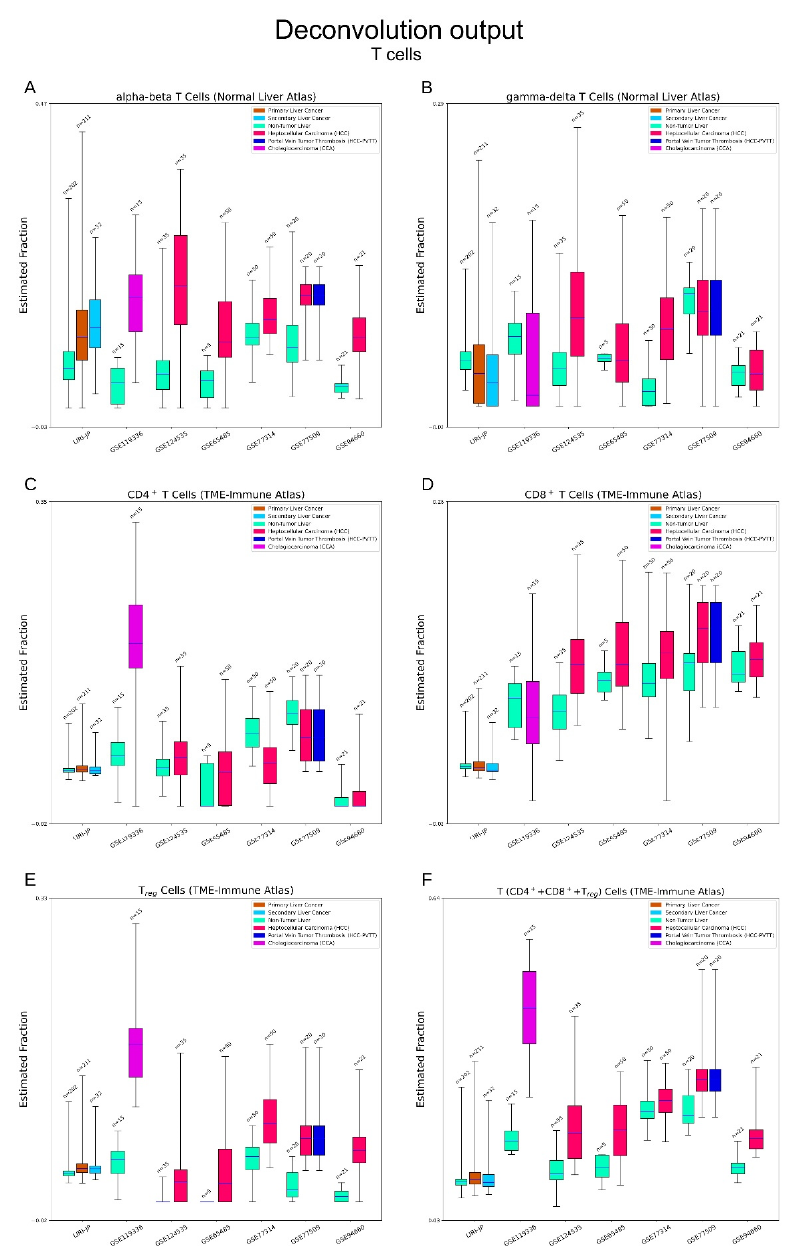
Figure 4. Deconvolution output—T cells. ( A – E ) Estimation of T cells. Alpha–beta ( αβ ) T cells and gamma–delta ( γδ ) T cells are from the Normal Liver atlas. CD4 + /CD8 + T cells and regulatory T (T reg ) cells are from the TME-Immune atlas. Overlap of cell type trees may exist between the two atlases. Obvious elevations of αβ T cells and obscure changes of γδ T cells can be seen in liver cancers. CD4 + T cells rise prominently in CCAs and CD8 + T cells moderately in HCCs. ( F ) Estimation of overall T cells. Higher activities of T cells can be seen in liver cancers.